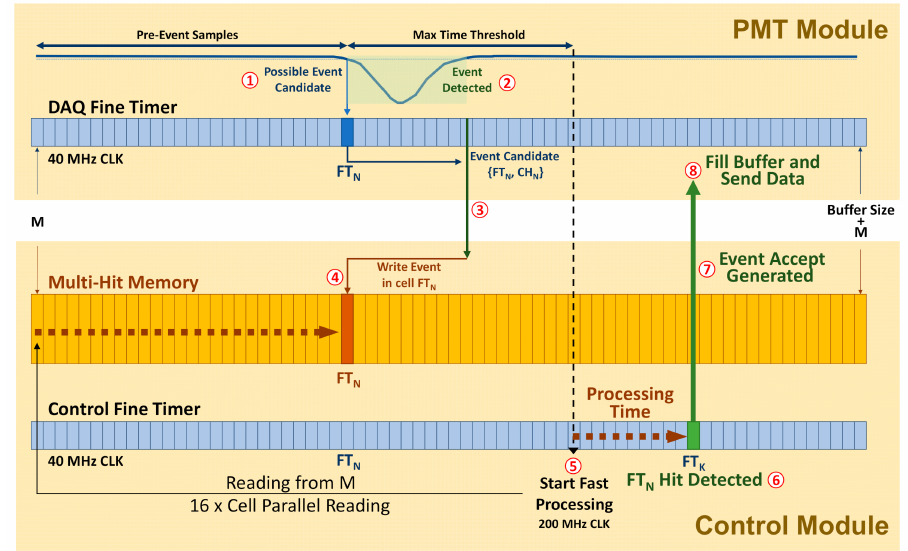
Figure 9. System event detection and Multi-Hit Memory scheme and functionality